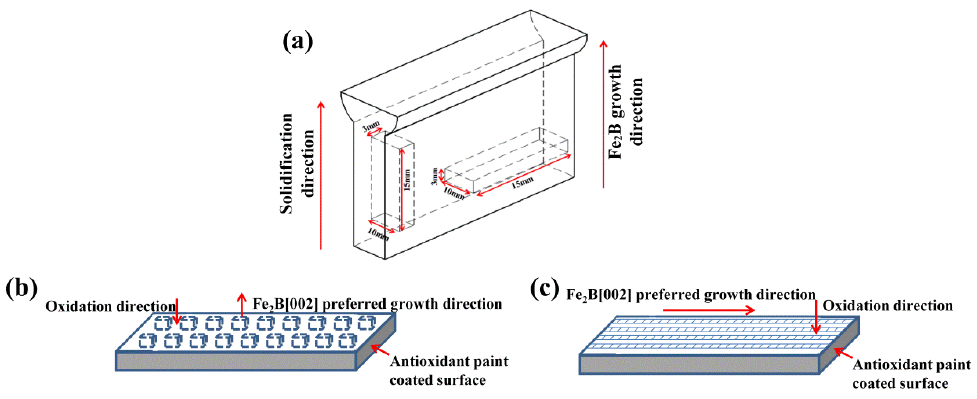
Figure 2. Schematic diagram of different oriented boride oxide samples: ( a ) Schematic diagram of sample position for high-temperature oxidation; ( b ) Fe 2 B // samples; ( c ) Fe 2 B ⊥ samples. Table 1. Chemical compositions of cast DS Fe – B alloy by spark emission spectrometer (wt.%). Samples